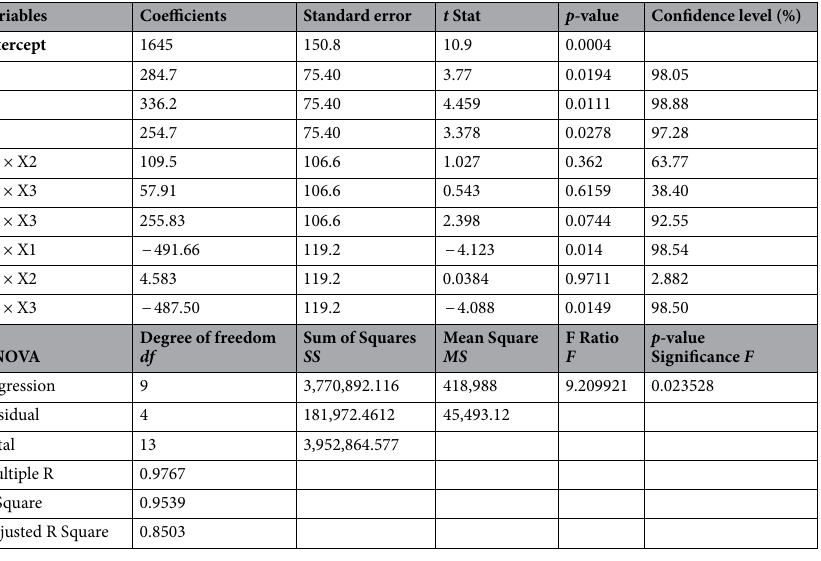
Table 2. S tatistical analysis of BBD showing coefficient values, t -values, p -values, and confidence levels for each variable on the protein content of the enzymatically treated feathers alongside with the ANOVA results of the